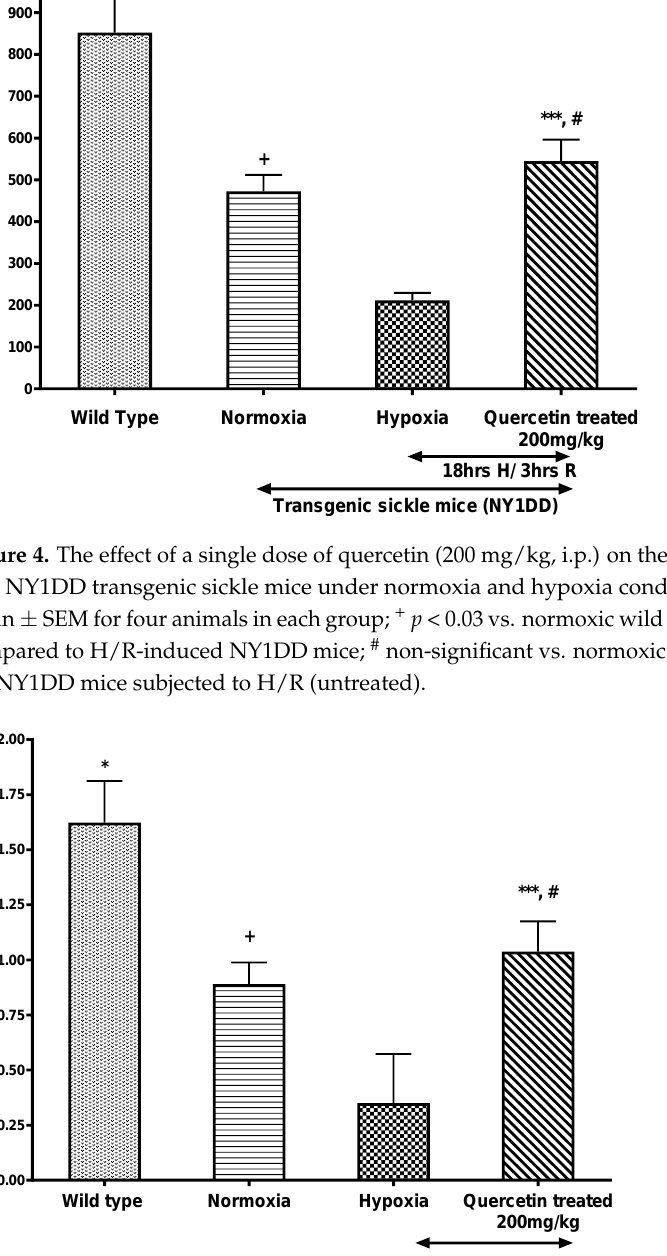
NY1DD subjected to H/R compared to normoxia in NY1DD mice (Figure 7). Treatment with quercetin at the onset of reoxygenation of NY1DD subjected to hypoxia reduced significantly ( p < 0.03) the concentration of sP-selectin, sE-selectin, and sVCAM-1 when compared to untreated NY1DD mice.